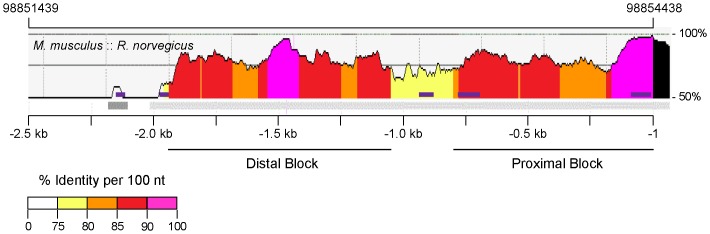
Conservation of the genomic region upstream of Bmp3 in M. musculus and R. norvegicus.A: Composite image adapted from ECR Browser aligning the regions upstream of the Bmp3 transcription start site between M. musculus and R. norvegicus. Threshold was set to ≥75% identity across sliding 100 nt window. This revealed a highly conserved 1.9 kb region proximal to the annotated transcription start site of M. musculus Bmp3. Within this region, there are two large blocks of ≥80% identity: a proximal one spanning from positions −1 to −806 and a distal one spanning positions −1057 to −1945. Each of these also contain a smaller region of ≥90% identity: −1 to −167 and −1408 and −1571, respectively. Genomic coordinates refer to location on M. musculus NC_000071.6. Gray bars indicate aligned segment. Purple boxes indicate repeat elements in M. musculus. Black region indicates 5′-end of Bmp3 exon 1 in M. musculus.